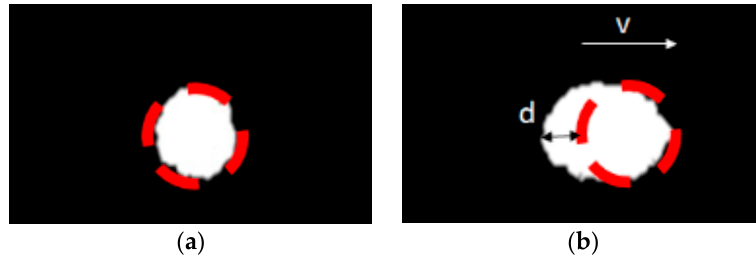
Figure 2. Shape distortion due to motion blur: ( a ) stopping object; ( b ) moving object.